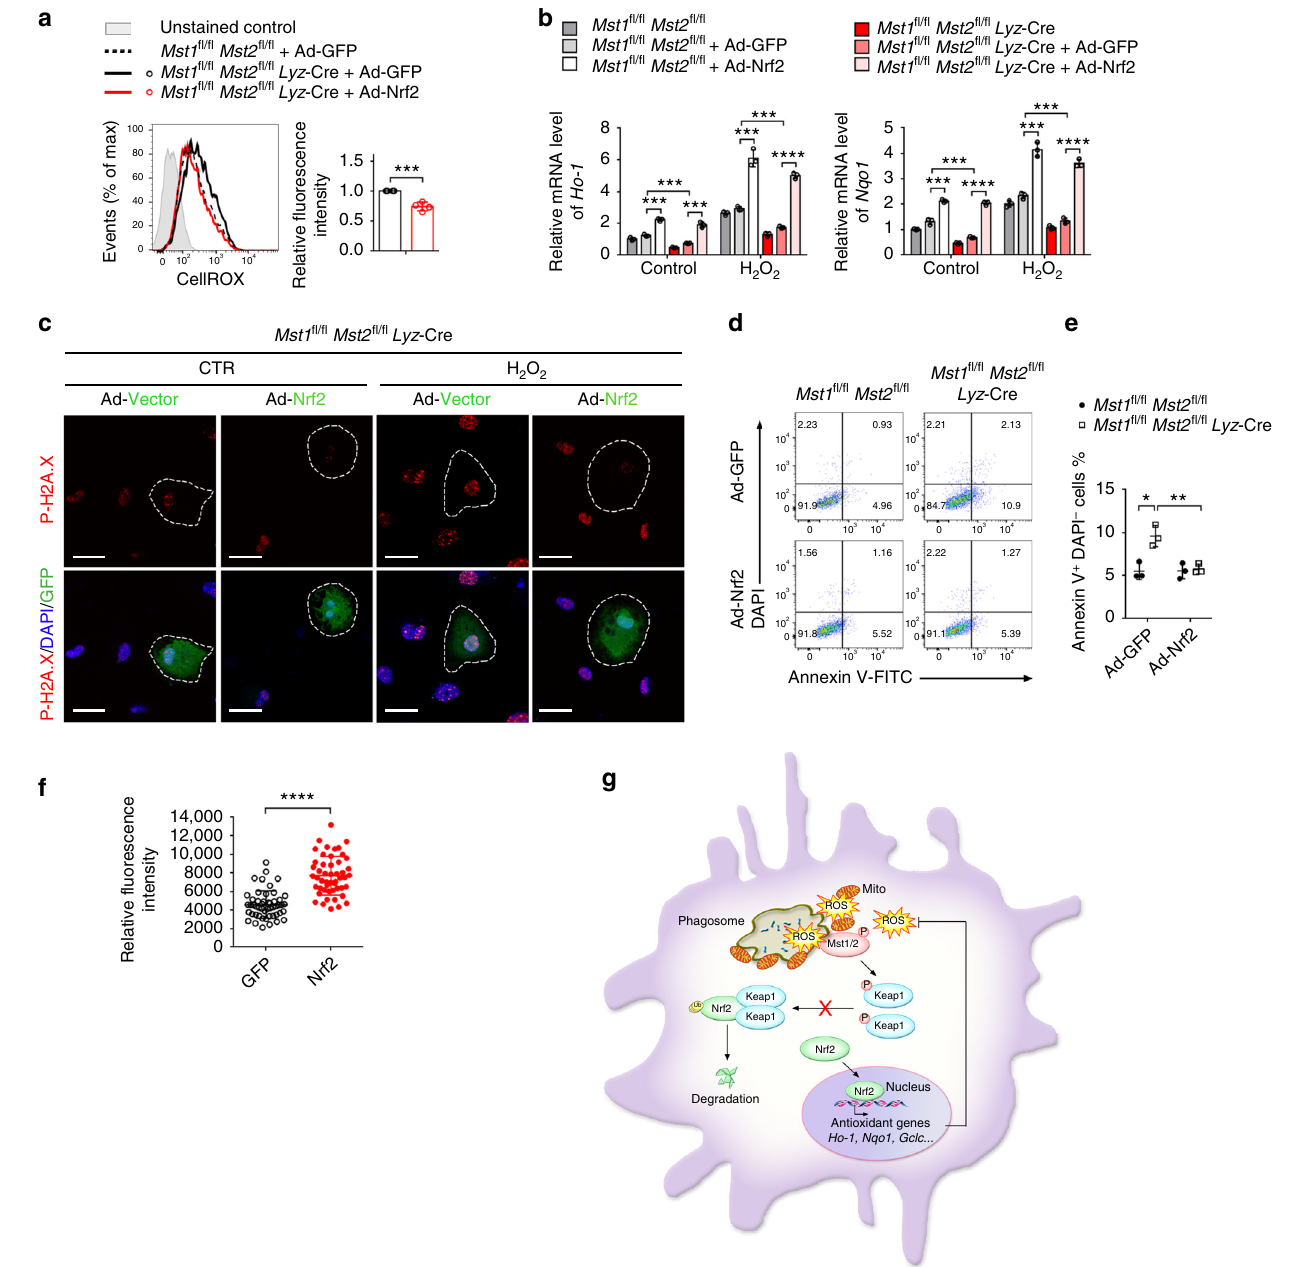
Fig. 8 Reintroduction of Nrf2 rescues the Mst1/2-null phenotype. a Flow cytometry analyzing of ROS levels in Mst1 fl / fl Mst2 fl / fl (WT) BMDMs, Mst1 fl / fl Mst2 fl / fl Lyz -Cre (DKO) BMDMs, or DKO BMDMs infected with adenovirus expressing GFP (Ad-GFP) or Nrf2 (Ad-Nrf2), with the CellRox dye and quanti fi cation of the relative fl uorescence intensity in the indicated cell samples shown in the right panel. b – e RT-qPCR analysis of the mRNA levels of the antioxidant genes Ho-1 and Nqo-1 ( b ), fl uorescence microscopy of p-H2A.X (red), DAPI-stained nuclei (blue) and GFP + cells (green) ( c ), Annexin V/DAPI staining ( d ) and quanti fi cation of Annexin V + DAPI − cells ( e ) in WT BMDMs, DKO BMDMs, or DKO BMDMs infected with Ad-GFP or Ad-Nrf2, followed with or without H 2 O 2 treatment as indicated. Scale bars, 20 μ m. f Relative fl uorescence intensities of telomere FISH of GFP + peritoneal macrophages isolated from WT mice transplanted for 6 months with DKO bone marrow cells, which were transduced with retrovirus expressing Nrf2, or control GFP, respectively. g A proposed working model for kinases Mst1/2 sense ROS and maintain cellular redox balance by modulating the stability of Nrf2. Phagosomal or mitochondrial ROS release attracts Mst1/2 to cap around phagosome or mitochondrion from the cytosol and activates Mst1/2; Mst1/2 phosphorylate Keap1 to stabilize Nrf2 and regulate the expression of antioxidant enzymes to protect cell against oxidative damage. Data are from one experiment representative of three independent experiments with similar results. ns, not signi fi cant ( P > 0.05); * P < 0.05, ** P < 0.01, *** P < 0.001, **** P < 0.0001, compared with the control sample (Student ’ s t test). Data are from one experiment representative of three independent experiments with similar results (mean and s.d. of n = 3 ( a , b , e ); mean and s.e.m. of n = 50 ( f ); biological replicates ( a , e ); and experimental replicates ( b , f